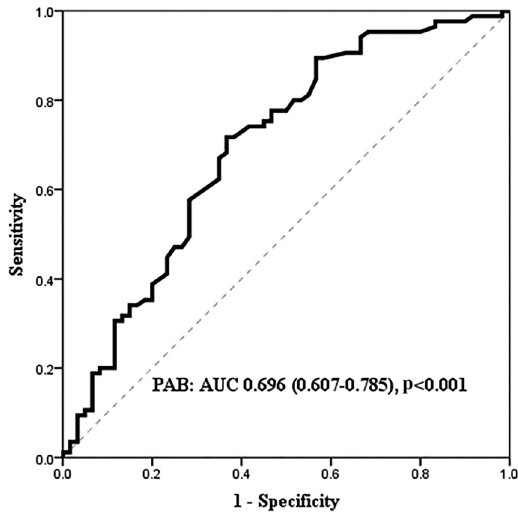
Figure 1: Characteristic feature of the curve.